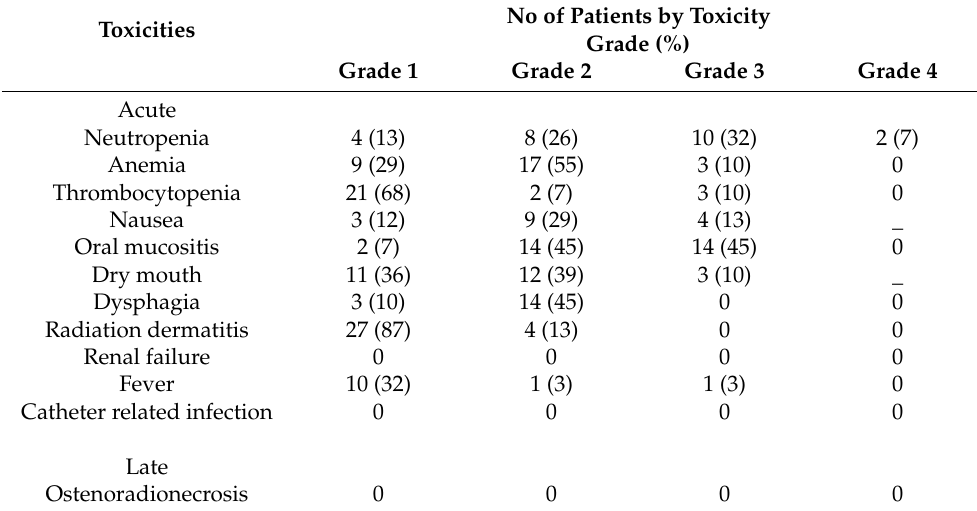
Table 2. Adverse events (NCI-CTCAE